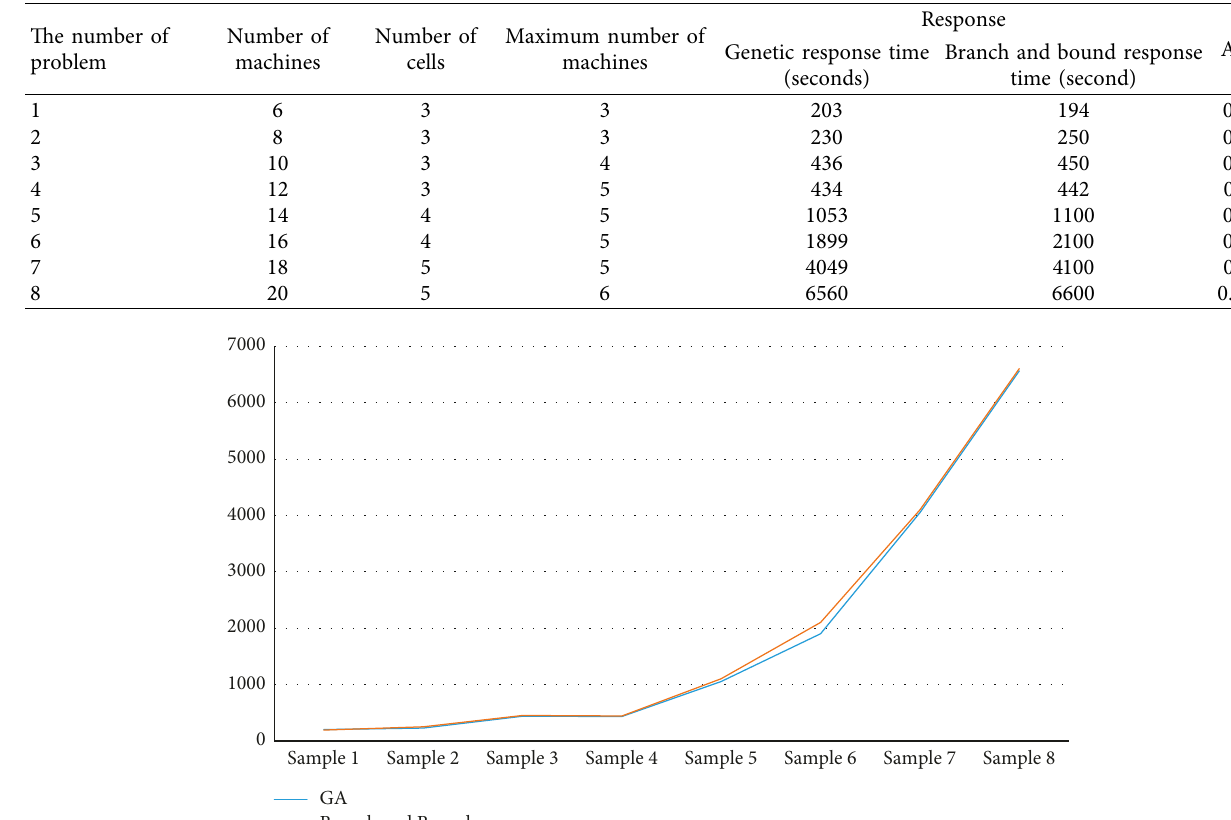
Table 4: Comparing the obtained results from branch and bound algorithm.